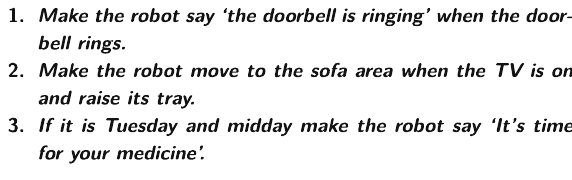
Figure 2: Initial set of behaviours taught to the robot during training of